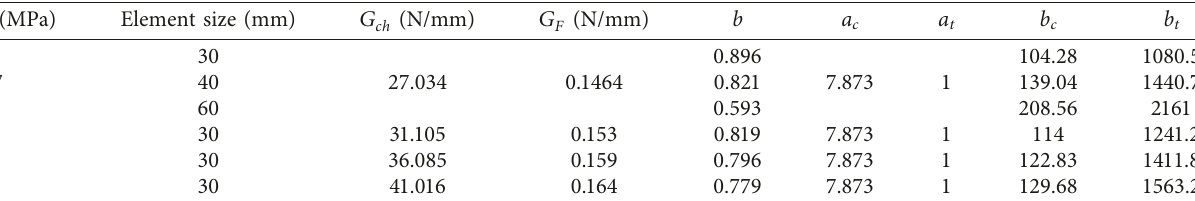
Table 1: Element size sensitivity parameters.